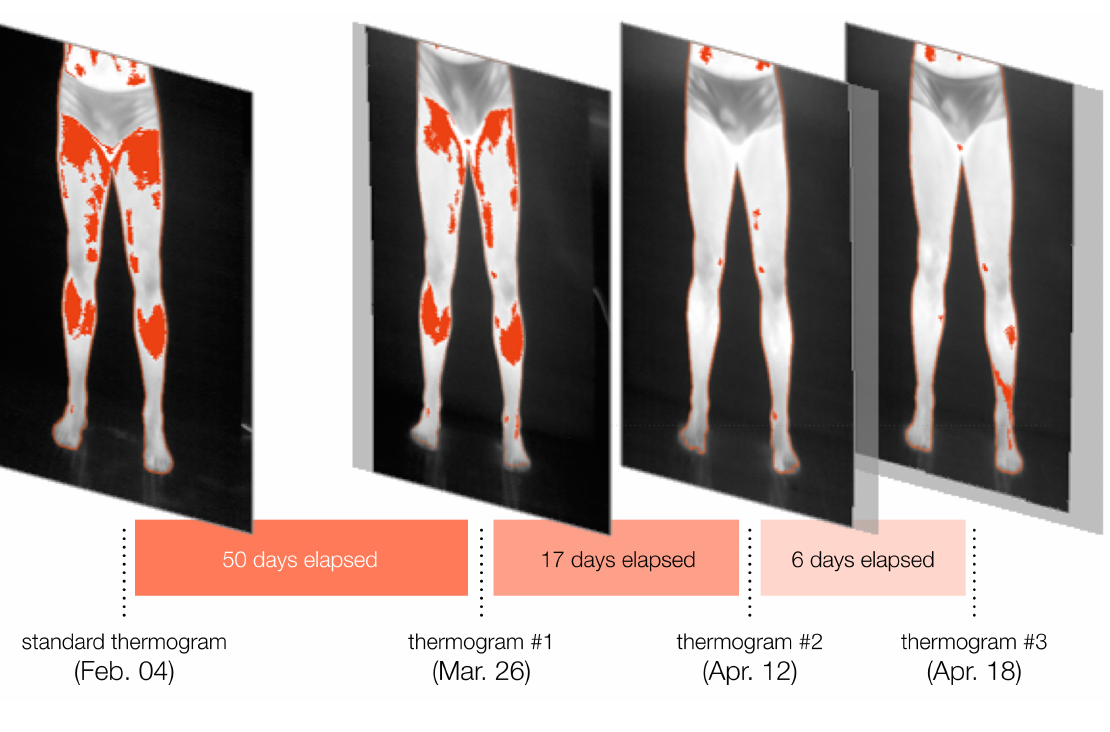
Figure 9. Example experiment on the progressive analysis of a sequence of thermograms of a volunteering player during the beginning of the season. The evolution of the player’s fitness is assessed qualitatively, through the observation of the registered images, and quantitatively, based on the region-growth